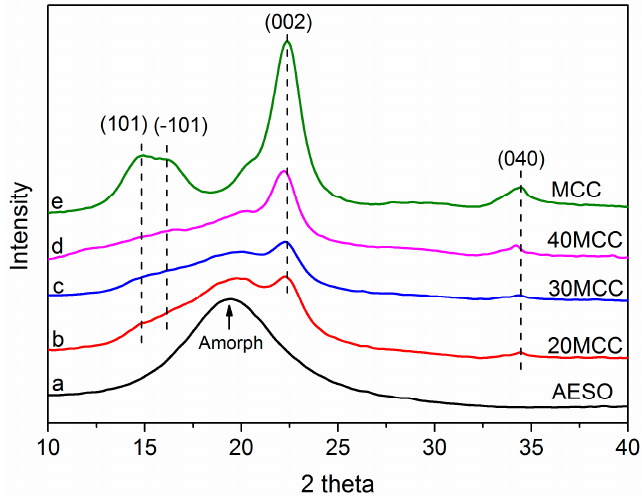
Figure 3. XRD patterns of pure MCC, AESO and MCC/AESO composites with different MCC loadings.